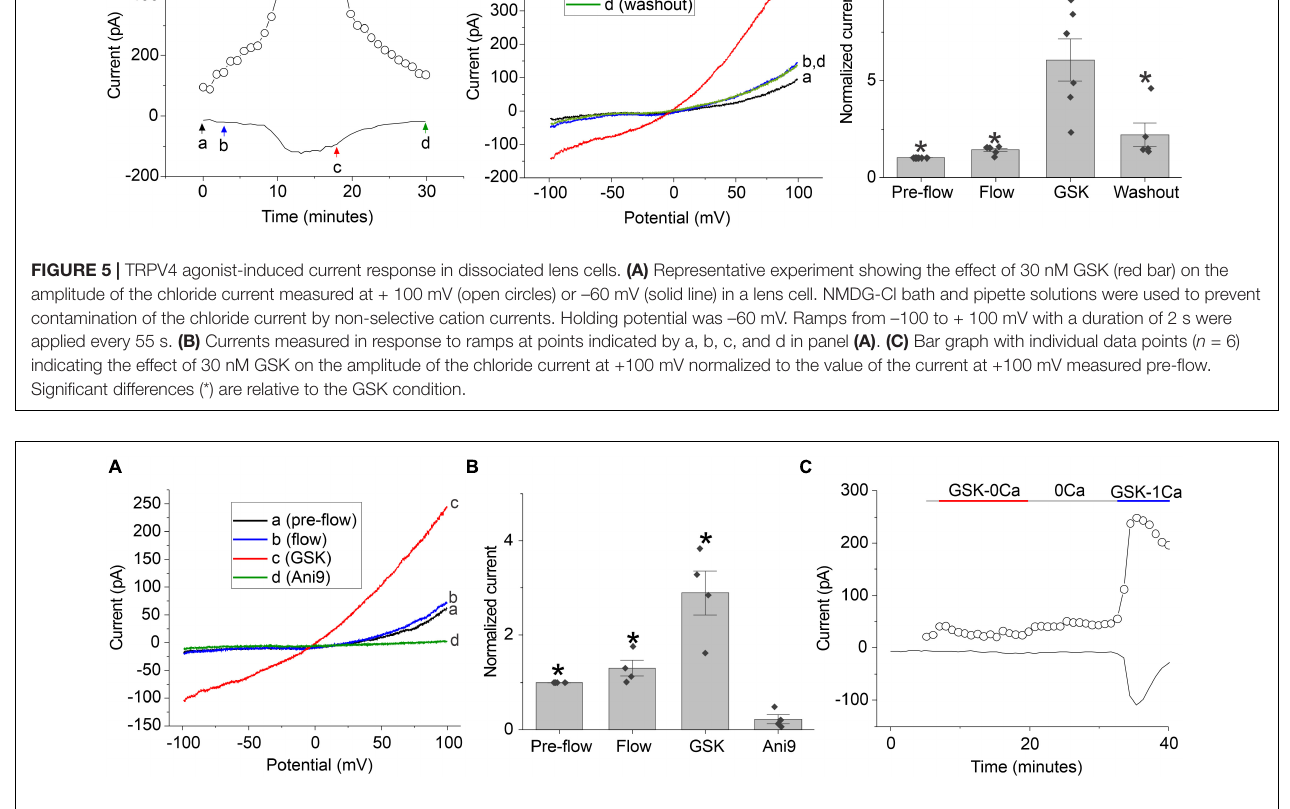
FIGURE 6 | GSK-induced chloride currents can be blocked by application of 5 µ M Ani9 or removal of external calcium. (A) Chloride currents evoked in response to ± 100 mV ramps of 2 s duration recorded pre-flow (black line), during flow (blue line), following application of GSK (red line) and after application of Ani9 (green line). (B) Bar graph summarizing the effect of 5 µ M Ani9 on the amplitude of the GSK-induced current at + 100 mV normalized to the value of the current at + 100 mV measured pre-flow ( n = 4). Significant differences (*) are relative to Ani9 treatment levels. (C) Representative experiment showing the effect of 30 nM GSK on the amplitude of calcium-activated chloride current measured at + 100 mV (open circles) and –60 mV (solid line) in NMDG-Cl bath solution, first in the absence of external calcium and then in the presence of 1 mM [Ca 2 + ] o . A robust, GSK-stimulated chloride current was only observed in the presence of 1 mM [Ca 2 + ] o . The pipette solution consisted of NMDG-Cl internal solution containing 100 nM [Ca 2 + ] i